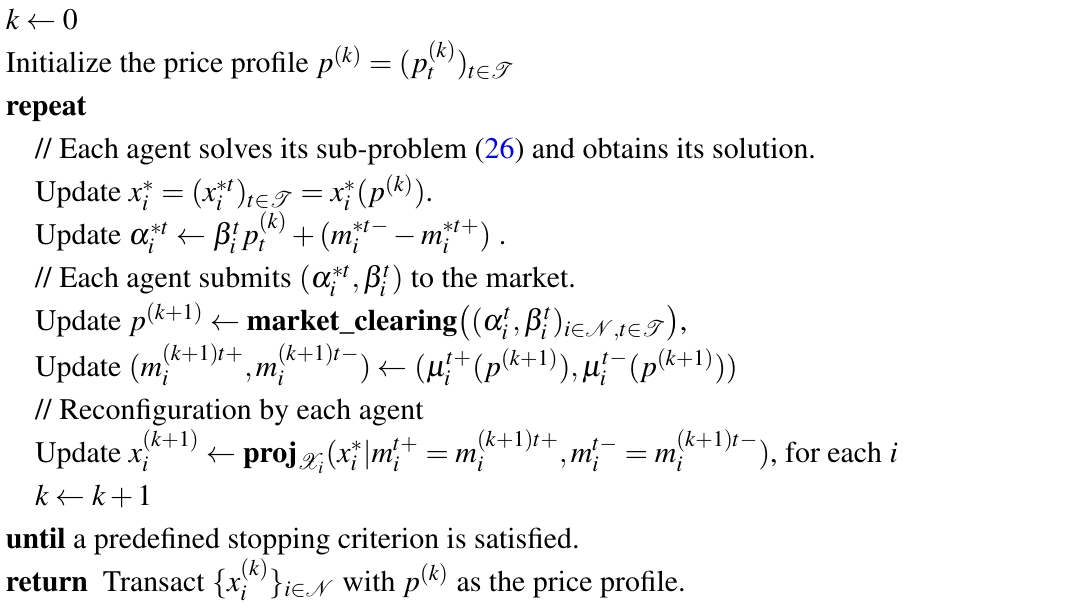
Algorithm 2 Iterative update in